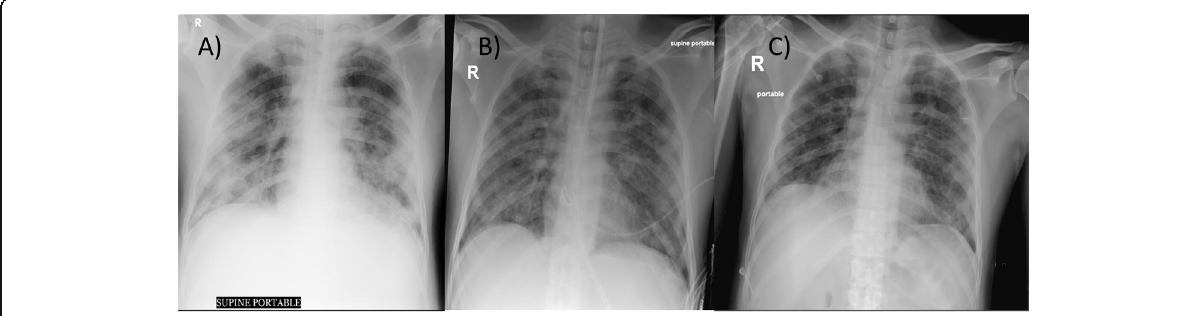
Fig. 7 Case 70: 47-year-old male, overweight (BMI 27.88) stayed at the ICU for 14 days, score 7, initially intubated, with post-critical polyneuropathy and grown Staphylococcus epidermidis Isolated from blood culture, resistant to Benzylpenicillin, Clindamycin, Erythromycin, Fusidic Acid, Oxacillin, Trimethoprim/Sulfa. Chest X-ray: a day of admission (April 17th). Extensive areas of diffusely organized